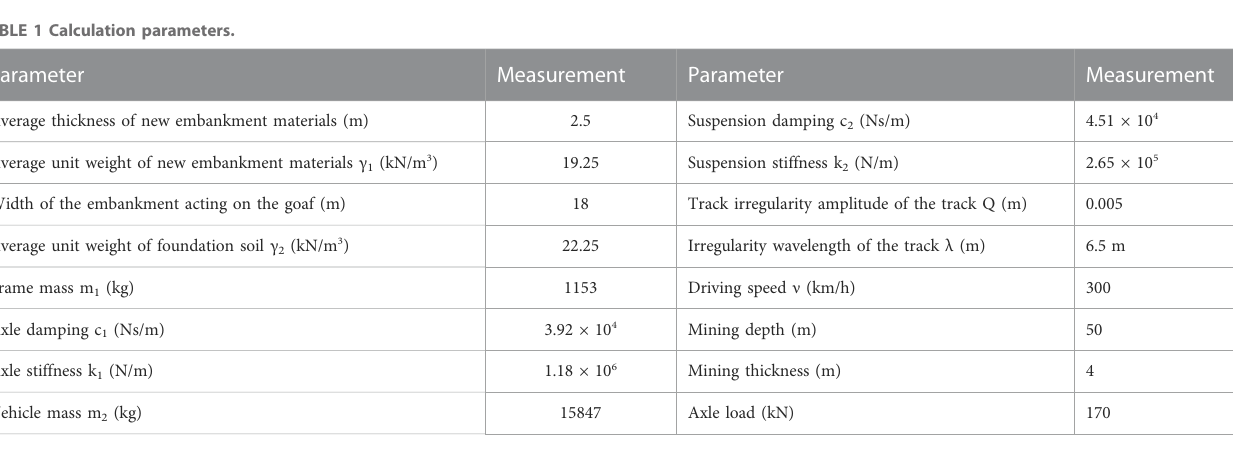
TABLE 1 Calculation